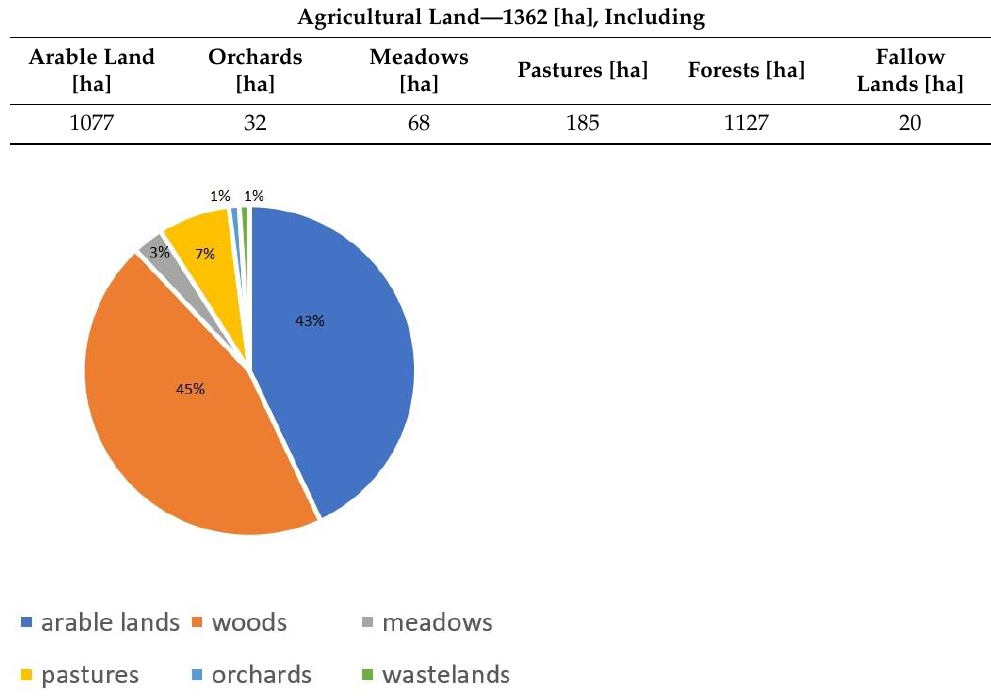
Table 1. The structure of land use.